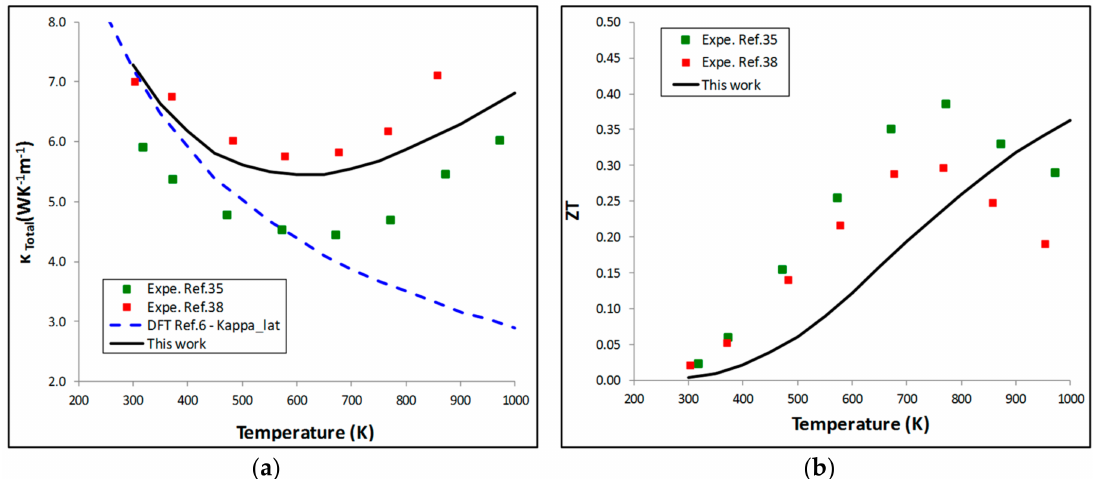
Figure 7. Evolution with temperature: ( a ) The thermal conductivity; ( b ) the figure of